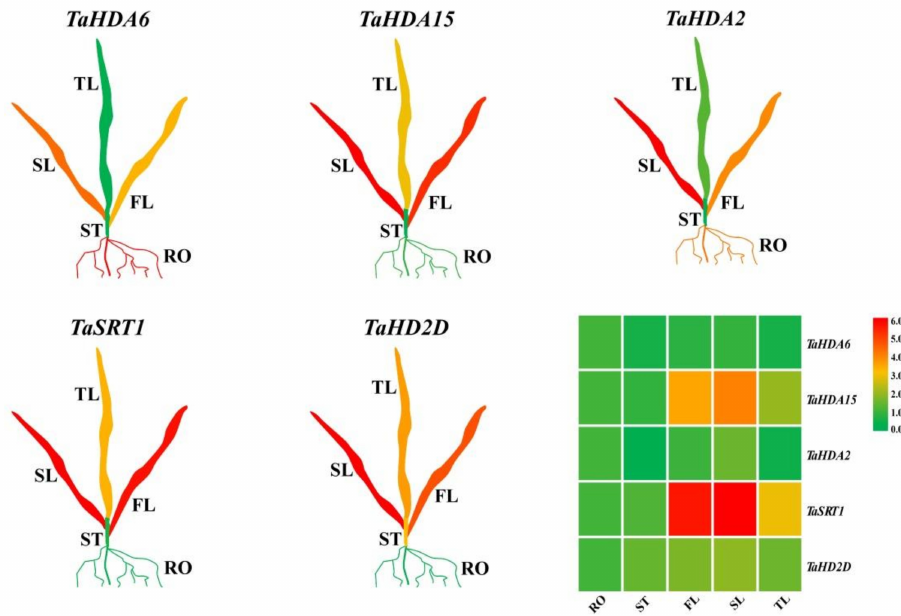
Figure 5. The expression level of representative TaHDAC genes in different tissues using real-time quantitative polymerase chain reaction (RT-qPCR) analysis. RO: root; ST: stem; FL: first leaf; SL: second leaf; TL: third leaf. The relative expression level of each biological sample was calculated based on 3 biological and 3 technical replicates. Red represents a high expression value, whereas green represents a low expression value. The relative expression level of TaHDAC genes was visualized using